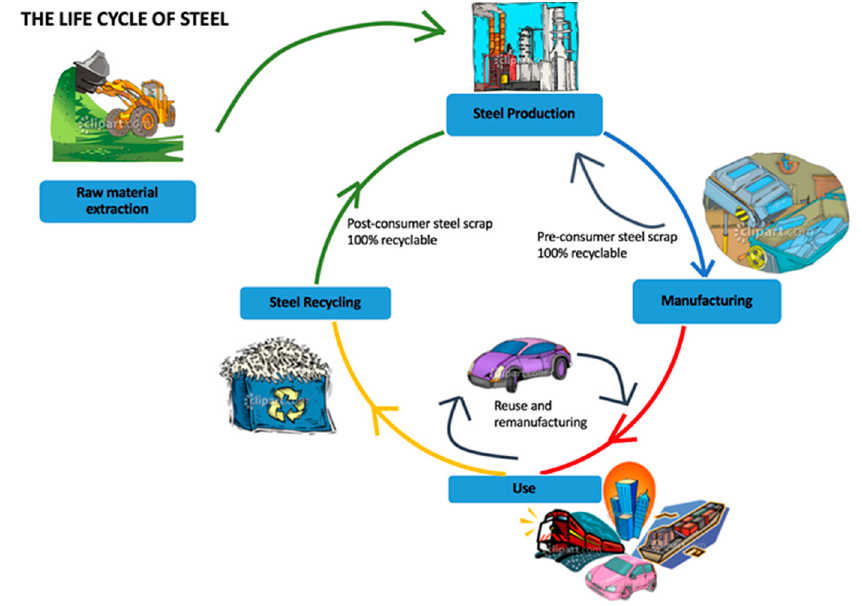
Figure 4. Life cycle of steel.